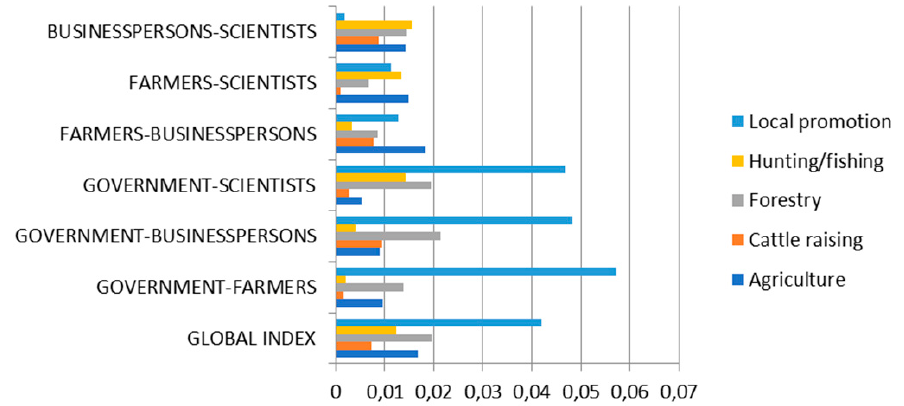
Figure 4. Global and specific indexes of conflict between each pair of stakeholders regarding development objectives.